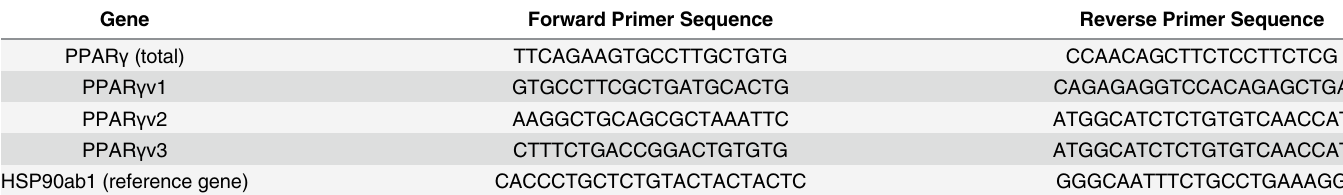
Table 1. Primer Sequences used in PCR Analyses of PPAR γ